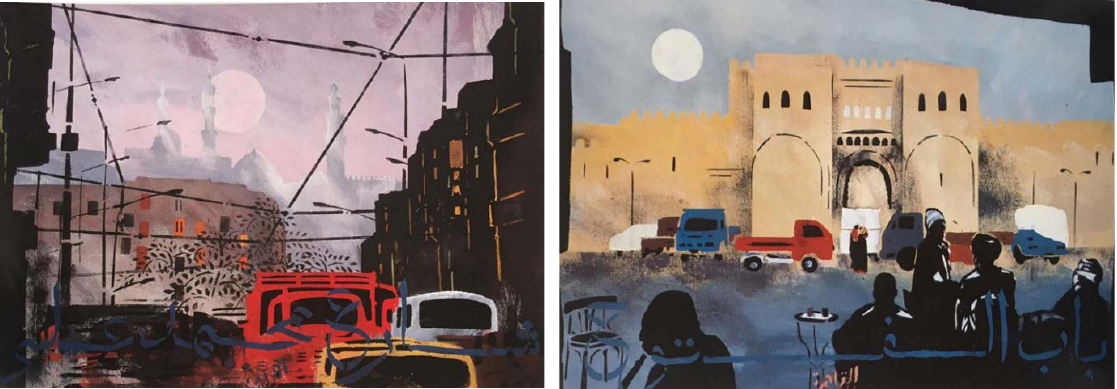
Figure 2 .Chant Avedissian: Mixed medis on paper, 50 x 70 cm 0.1992 to 1996